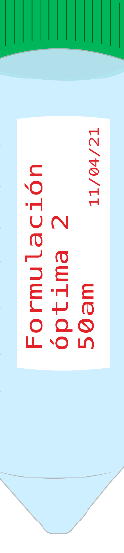
Table 9. Load capacity and encapsulation efficiency of methacrylic acid–ethyl acrylate copolymer nanoparticles. Figure 9. Formulation of optimized glibenclamide NPs. Figure 9. Formulation of optimized glibenclamide NPs. Table 8. Size, PDI, and zeta potential of the optimal MA/EA NP formulation. Table 8. Size, PDI, and zeta potential of the optimal MA/EA NP formulation.